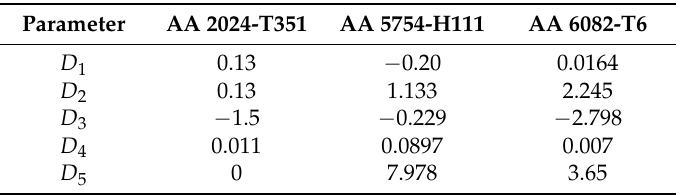
Table 5. Johnson-Cook failure model